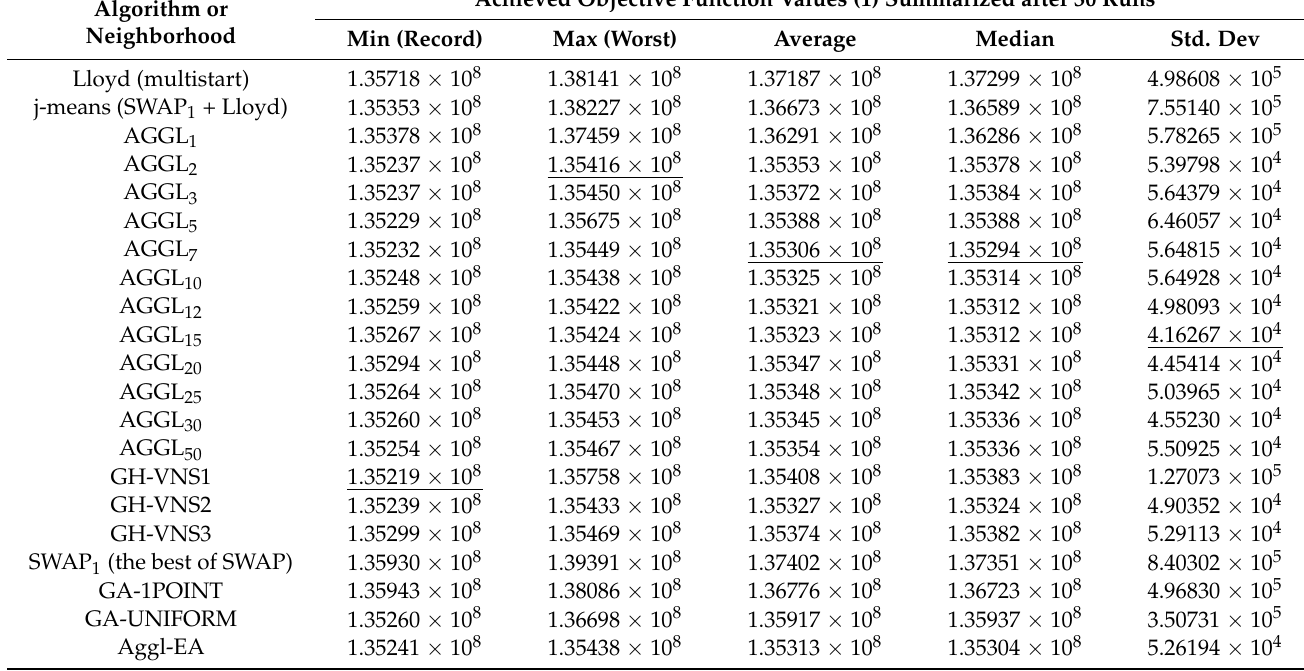
Table A7. Comparative results for S4 dataset. 5000 data vectors in R 2 , p = 50 centers, time limitation 1 s. Algorithm or